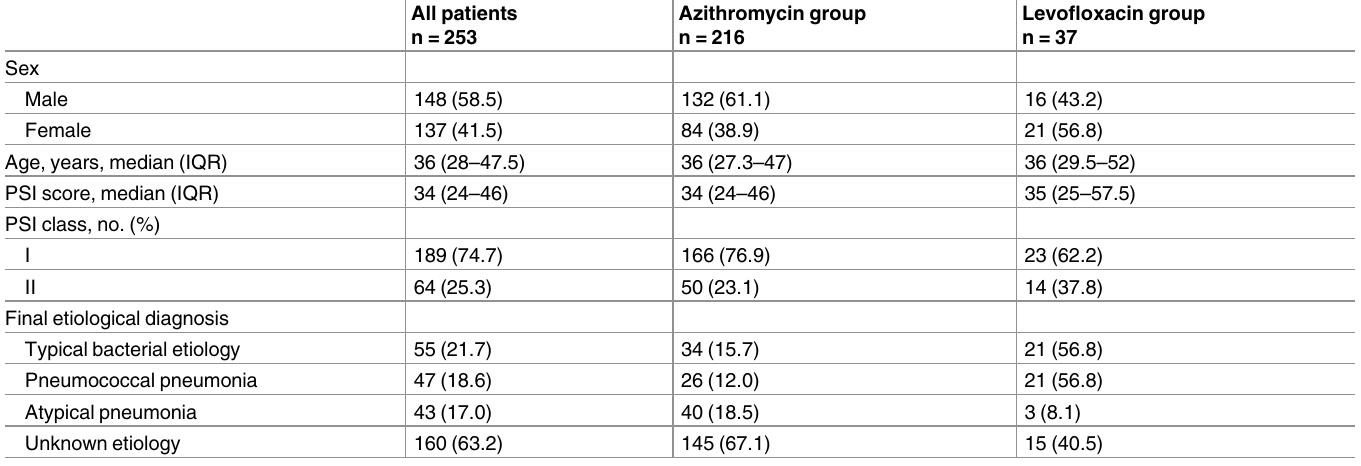
Table 1. Baseline characteristics of the patients and established etiological